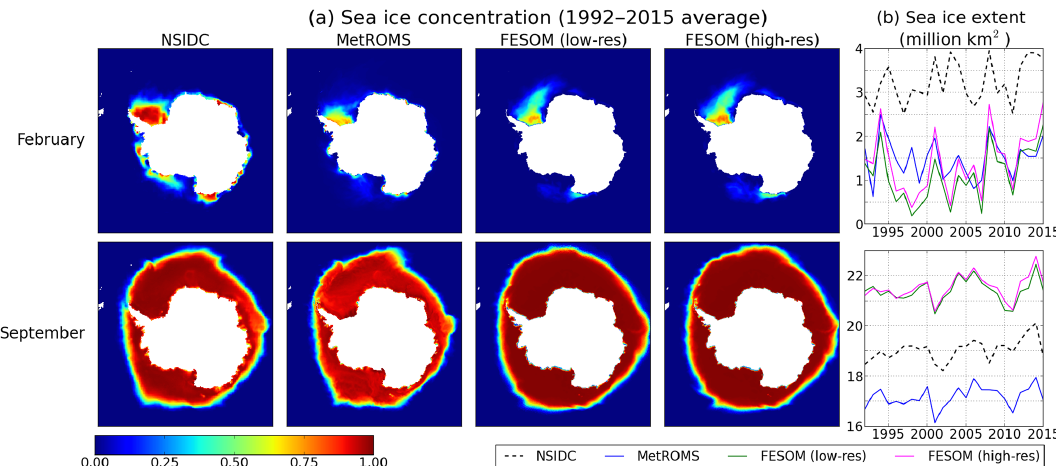
Figure 6. (a) The 1992–2015 mean Antarctic sea-ice concentration for February (top) and September (bottom), comparing NSIDC obser- vations (NOAA/NSIDC Climate Data Record of Passive Microwave Sea Ice Concentration) (Meier et al., 2013), MetROMS, low-resolution FESOM, and high-resolution FESOM. (b) Time series of total Antarctic sea-ice extent in millions of km 2 for February (top) and September (bottom), comparing NSIDC observations (NSIDC Sea Ice Index version 2) (Fetterrer et al., 2016), MetROMS, low-resolution FESOM, and high-resolution